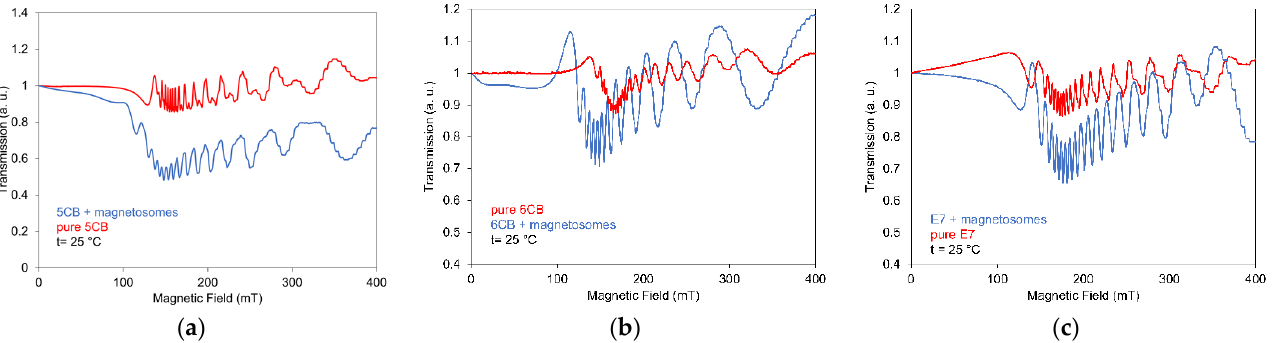
Figure 13. Effect of magnetic field on light transmission for 5CB ( a ) 6CB ( b ) and E7 ( c ) doped with magnetosomes of concentrations 0.2 wt% ( a ) compared with that of corresponding pure LCs.